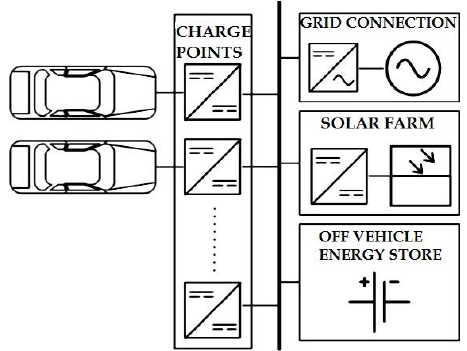
Figure 8. Block schematic of EV charging station.